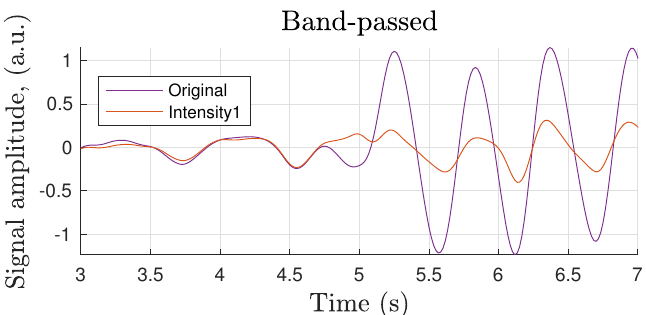
Figure 13. 0.6–3 Hz band-pass filtered segment showing in-band motion-induced noise suppression by image